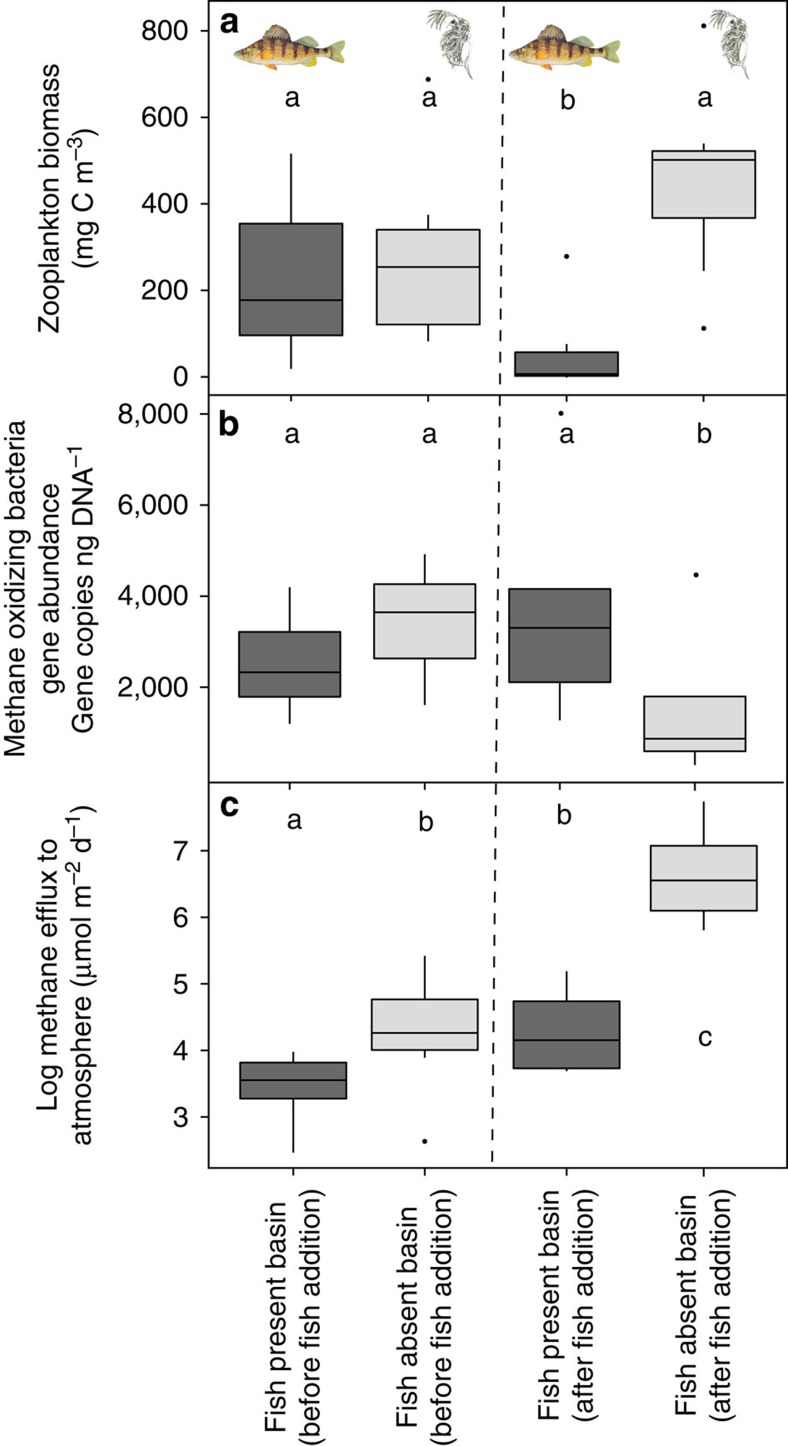
Fish presence affects zooplankton abundance, abundance of MOB and calculated methane efflux from lake to atmosphere.Box-and-whisker plots for the fish-present and fish-absent treatments for both the pre-fish period and the post-fish addition. The line across the box represents the median, the box edges represent the upper and lower quartile, and the whiskers represent the 95th percentile. Single data points are considered to be outside the 95th percentile, however, in most cases the data were not excluded from analysis. (a) Fish presence significantly decreased zooplankton abundance over time (Welch t-test: t=3.2157, df=8, P=0.01) whereas when fish were absent there was no change in abundance with time observed (Welch t-test: t=−1.1822, df=8, P=0.26) and significantly higher zooplankton abundance (Paired t-test: t=−4.449, df=8, P=0.0030). (b) A significant decrease in MOB gene abundance over time is seen in the absence of fish (Welch t-test: t=4.543, df=9, P=0.0016) while there is no significant change in MOB gene abundance when fish were present (P>0.05) leading to a significant difference between the treatment basins (Paired t-test: t=4.1639, df=4, P=0.0141). (c) A significant seasonal increase in methane efflux from lake to atmosphere occurs under both fish presence (Welch t-test: t=−2.4134, df=9, P=0.0448) and absence treatments (Welch t-test: t=−4.9689, df=9, P<0.001). However, the significant difference between basins (Paired t-test: t==4.062, df=6, P=0.027) is a striking 9.9 times more efflux when fish are absent compared with only a 150% increase when fish are present.